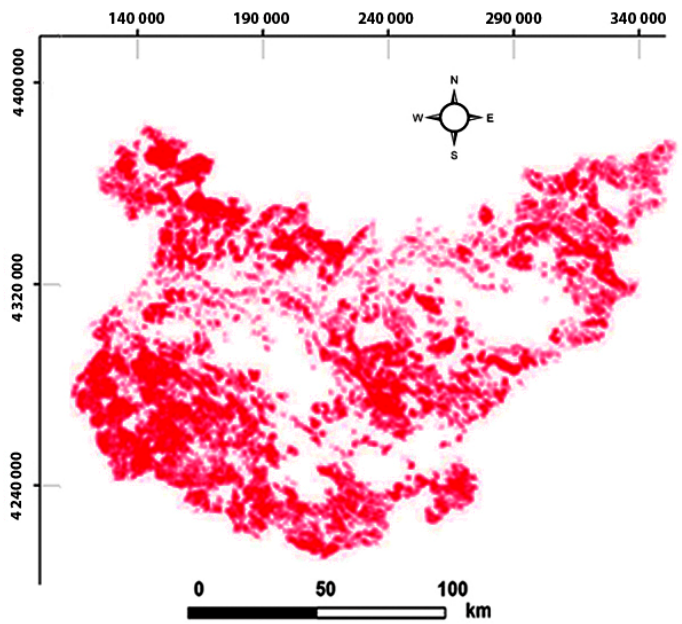
Figure 2. Map of forest exploitable area.